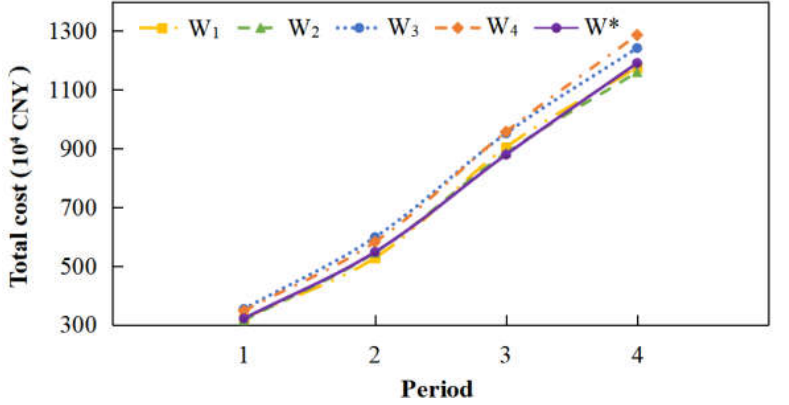
Figure 2. Distribution time of emergency materials in each time period under different decision criteria.